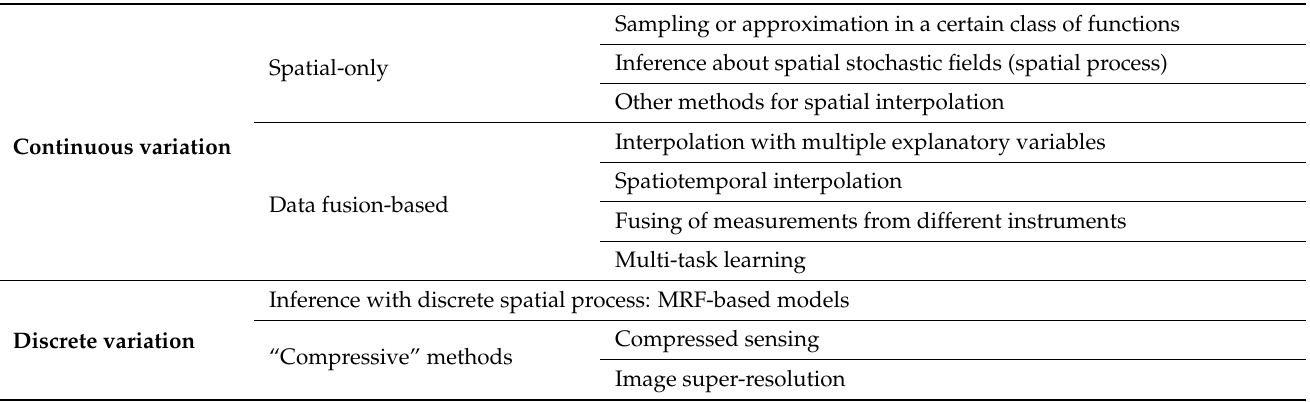
Table 2. Classification framework for interpolation